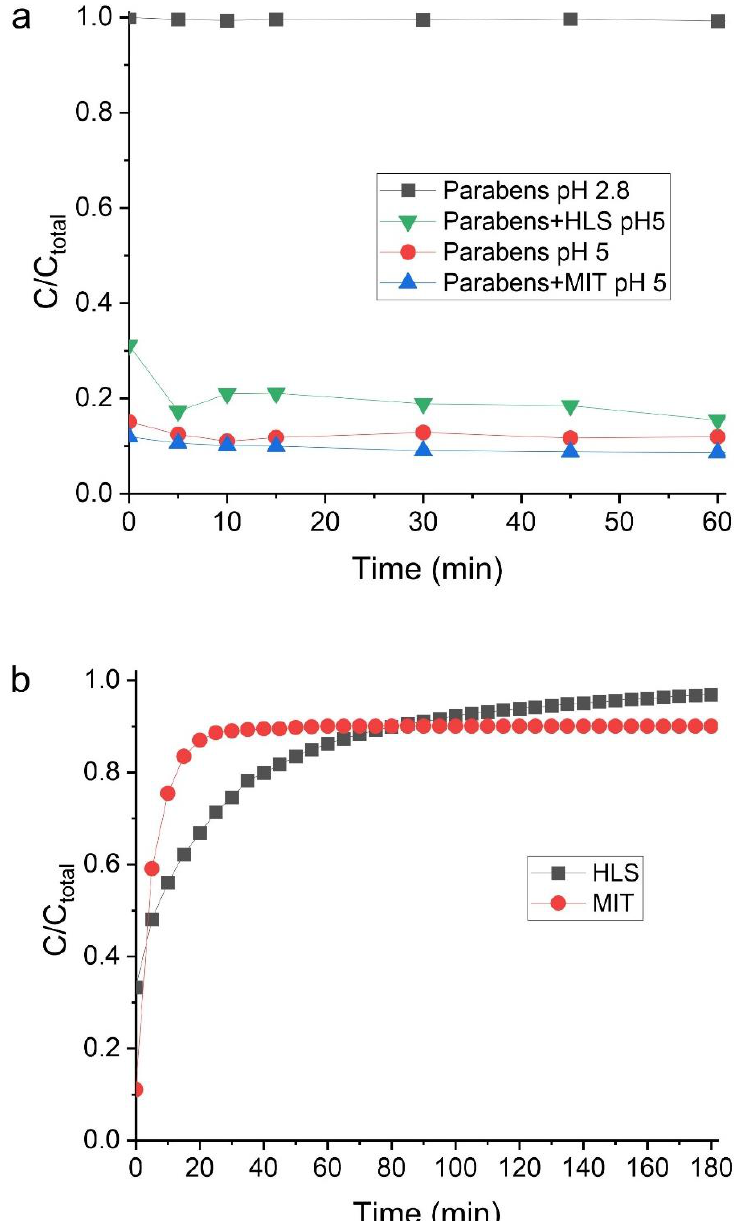
Figure 9. ( a ) Iron in solution measured by the colorimetric method; ( b ) stability of iron with different complexing agents through to time at pH 5. [MIT] = 5 mg·L −1 , [Fe (III)] = 5 mg·L −1 , [HLS Coffee] = 25 mg·L −1 .